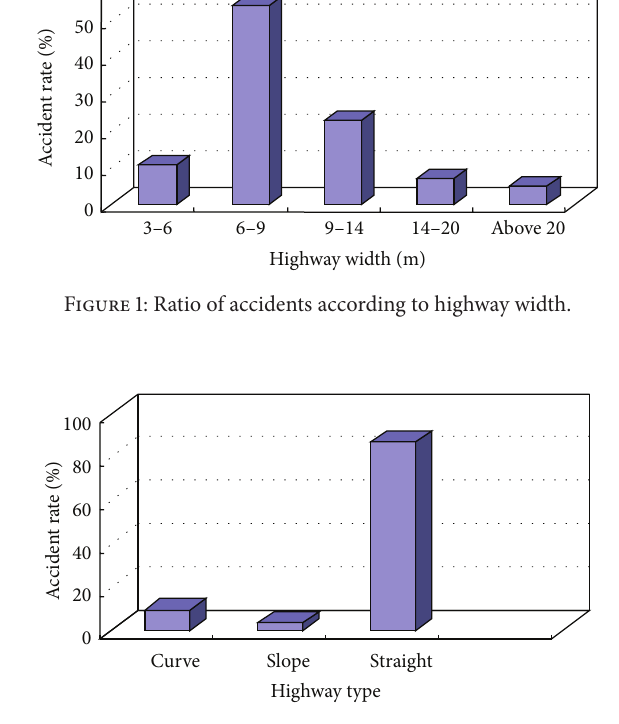
Figure 2: Ratio of accidents according to highway